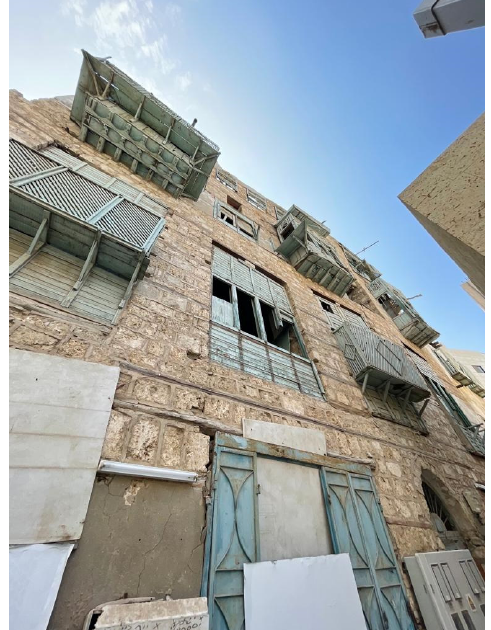
Figure 4. Facade of one of Jeddah’s historic houses.